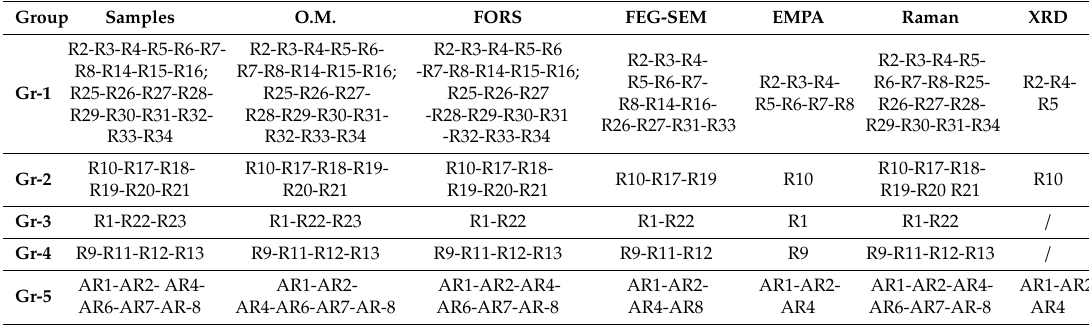
Samples investigated by UV–VIS spectroscopic measurements and chemical and mineralogical